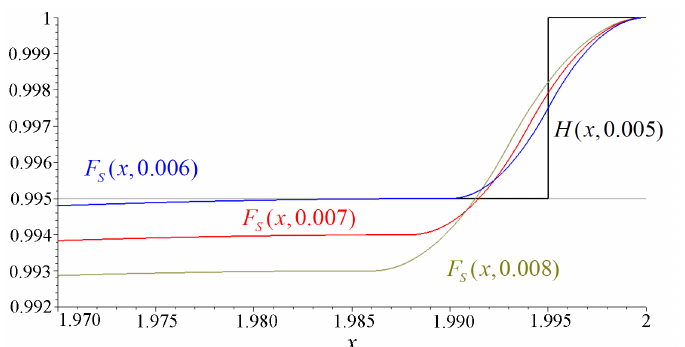
Figure 9: Plots of F S ( x , 0.005 + ε ) for ε ∈ { 0.001, 0.002, 0.003 } and H ( x , 0.005) in Example 2.